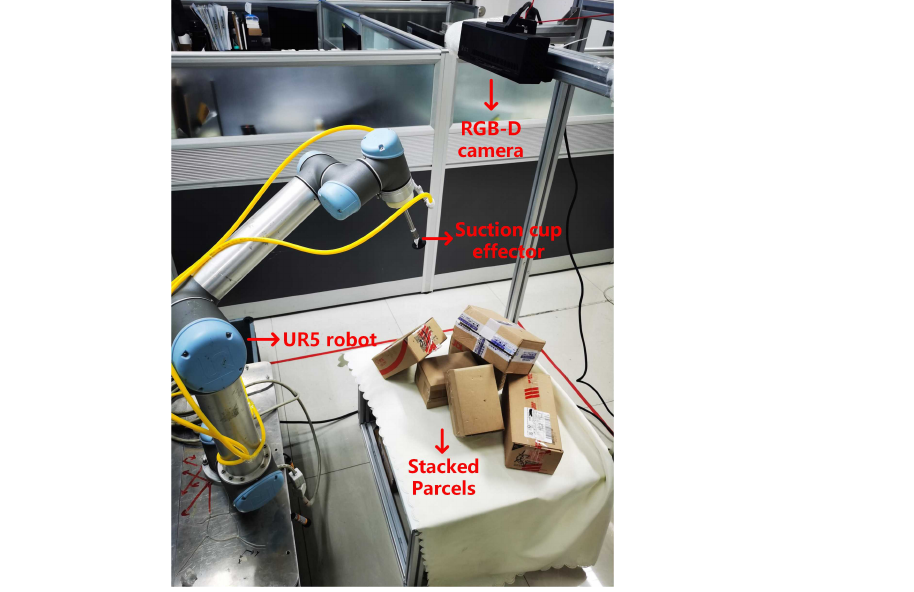
Figure 8. The robot sorting experimental platform mainly includes a UR-5 6-DOF robot, a RGB-D camera and a sucker actuator. Table 1. The object detection network’s hyperparameter setting.